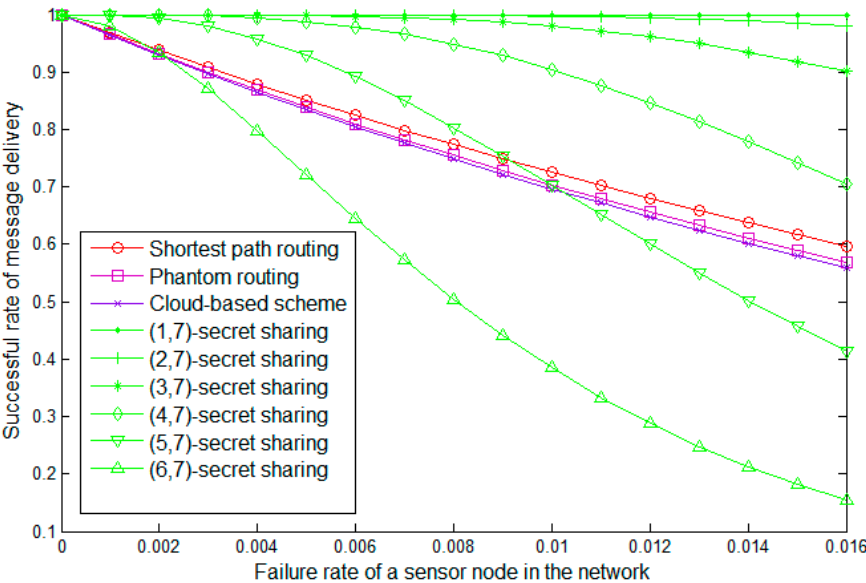
Figure 10. Successful rate of message delivery between the source node and the sink node.